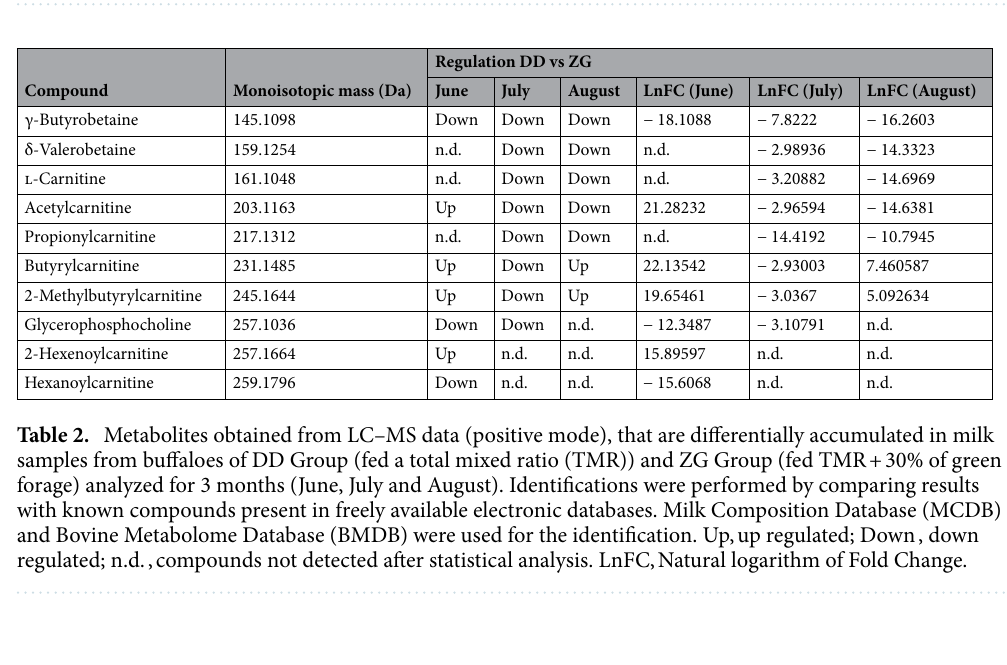
Figure 1. PCA score plots of the LC–MS data acquired for the three milk samplings from buffaloes DD Group fed a total mixed ratio (TMR) (red squares) and ZG Group fed TMR + 30% of green forage (blue triangles). ( A ) (June sampling): PC1 accounts for 50.85% and PC2 21.45% of total variance; ( B ) (July sampling): PC1 variance 63.64% and PC2 variance 12.46%; C) (August sampling): PC1 variance 65.66% and PC2 variance 14.57%.